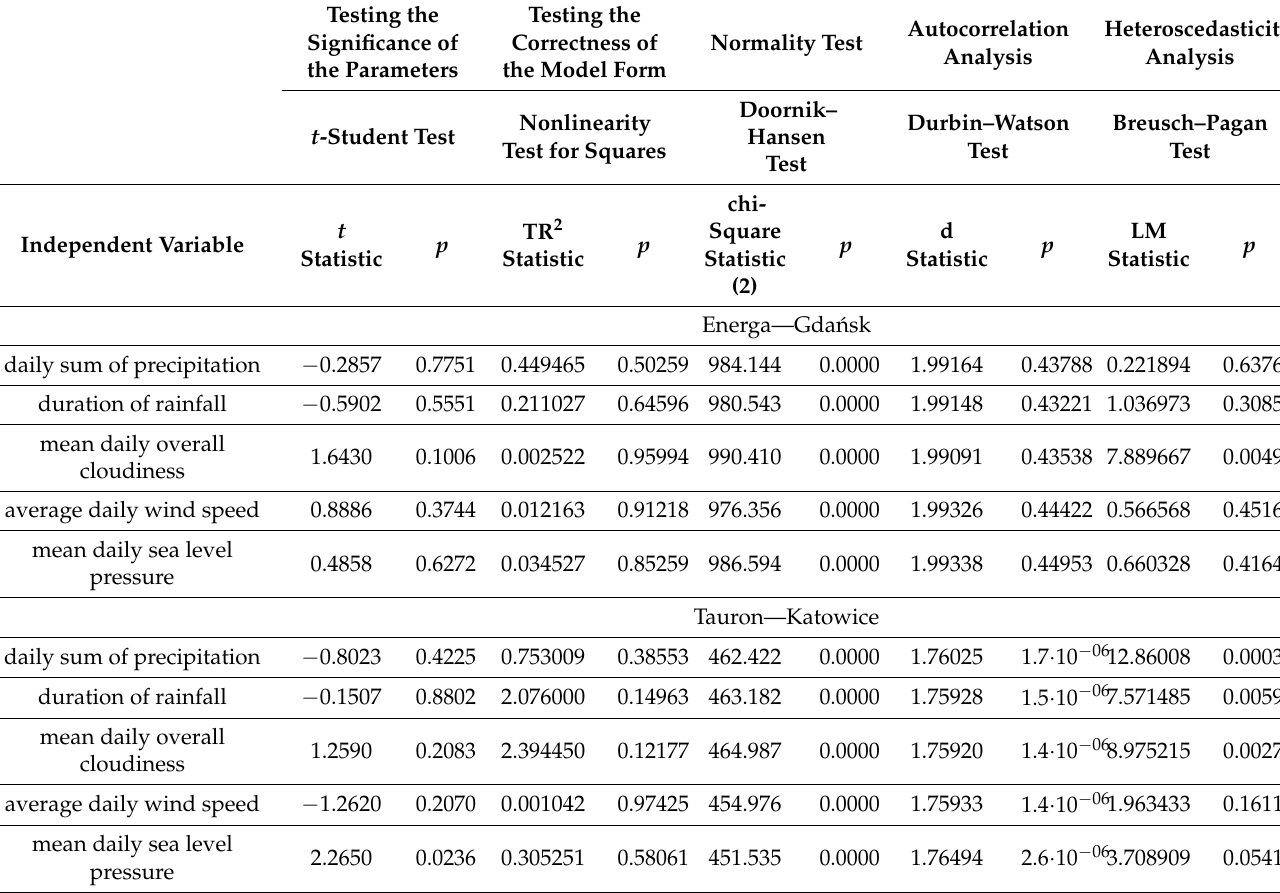
Table 5. OLS estimation results for the rate of return depending on the one-period stationary lag of the weather factor together with testing the properties of the residual